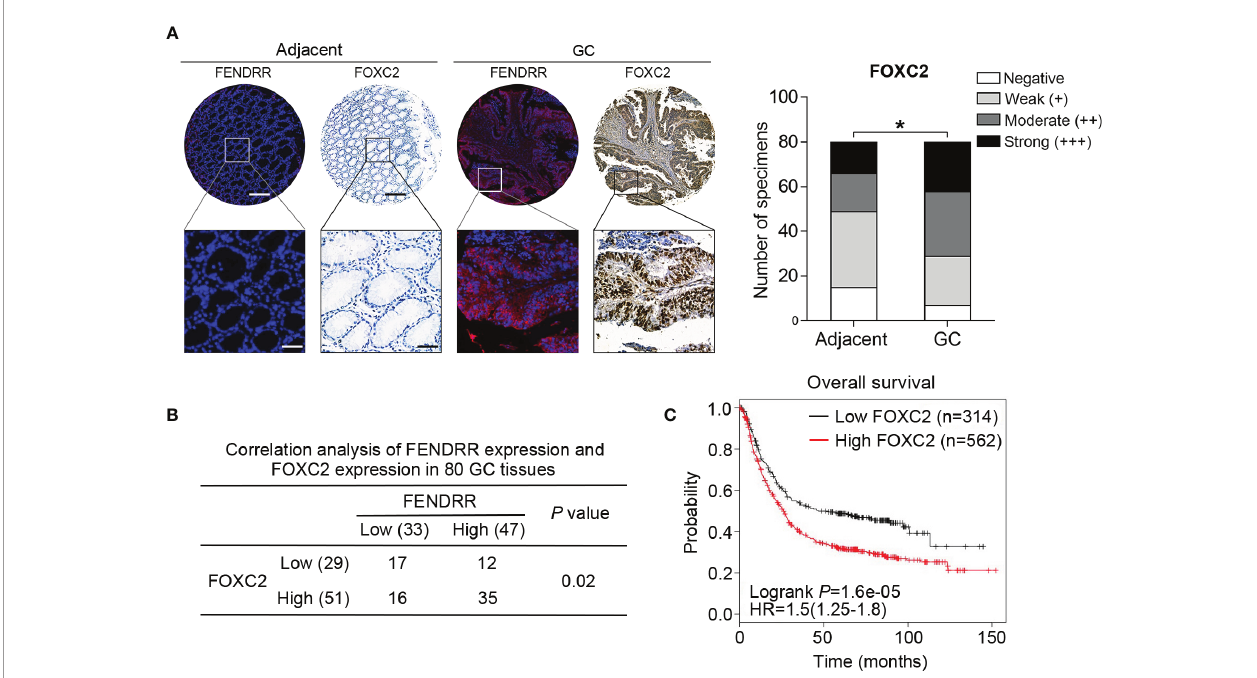
FIGURE 6 | Positive correlation between FENDRR and FOXC2 expression in human GC tissue samples (A) Representative images of FENDRR and FOXC2 expression in 80 paired GC and adjacent normal tissue samples detected by FISH and IHC, respectively (left). Scale bar, 200 m m (low magni fi cation) or 50 m m (high magni fi cation). Analysis of immunohistochemical staining for FOXC2 in 80 paired CRC specimens and matched adjacent normal tissue samples (right). (B) Correlation between the expression of FENDRR and FOXC2 in 80 GC patients. (C) Kaplan-Meier analysis of the correlation between FOXC2 expression and overall survival in patients with GC. * P < 0.05, error bars, s.d.